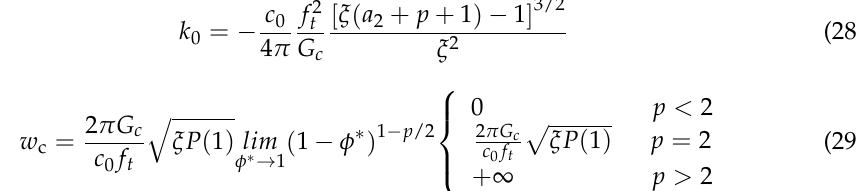
Figure 2. Schematic illustration of sharp ( 𝛤 , left) and diffusive ( ℬ , right) crack topology in a 2D solid 𝛺 with its external boundary ∂𝛺 . The external boundary ∂𝛺 can be divided into two parts: ∂𝛺 (cid:3047) and ∂𝛺 (cid:3048) , with ∂𝛺 (cid:3047) ∩ ∂𝛺 (cid:3048) = ∅ and ∂𝛺 (cid:3047) ∪ ∂𝛺 (cid:3048) = ∂𝛺 , in which it is given displacements 𝒖 ∗ for ∂𝛺 (cid:3048) and tractions 𝒕 ∗ for ∂𝛺 (cid:3047) , respectively. The outward unit normal vector of external boundary ∂𝛺 is denoted as 𝒏